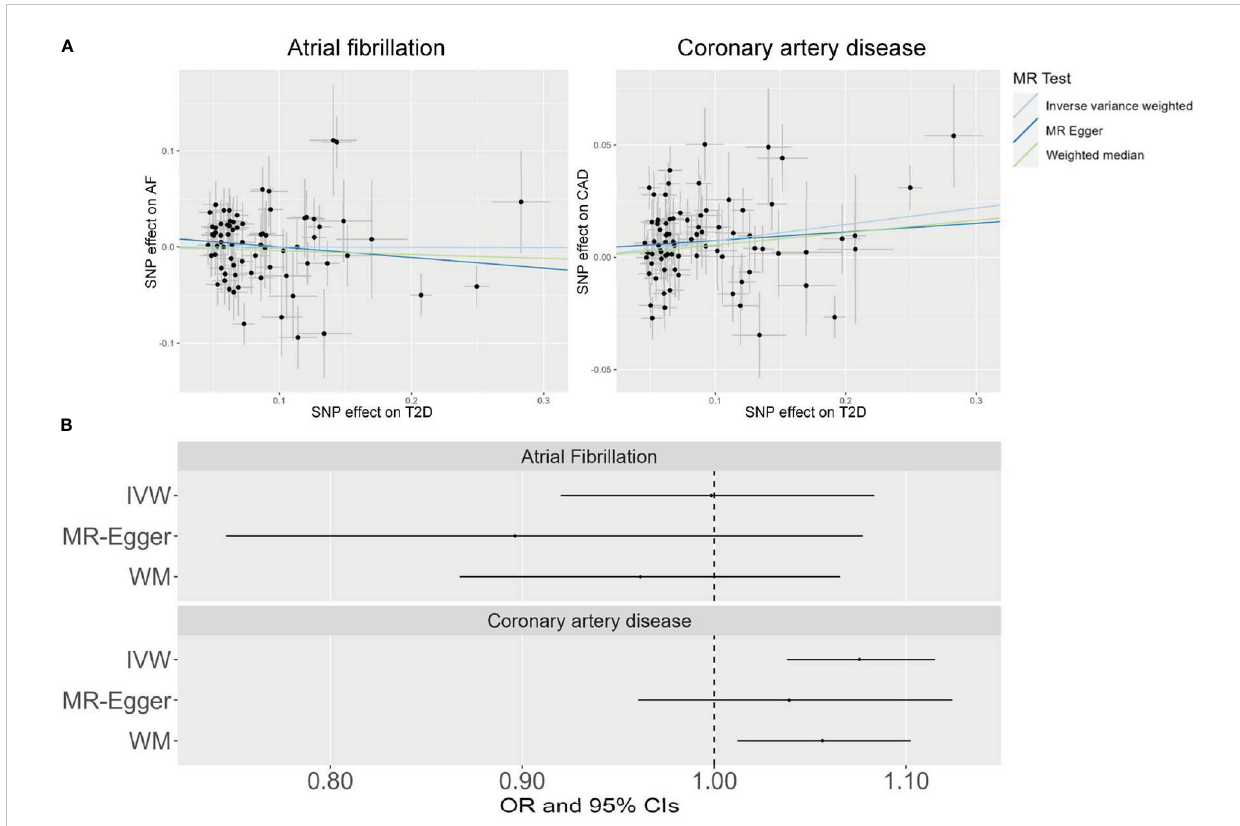
out of the 49 traits, six were associated with T2D at suggestive levels of evidence ( P < 0.05) (Figure 2 and Supplementary Tables 2-3). comparisons (Supplementary Table 4). Reverse MR analyses suggested that alkaline phosphatase was the only trait that could not be altered by T2D (Figure 3 and Supplementary Tables 2-3).